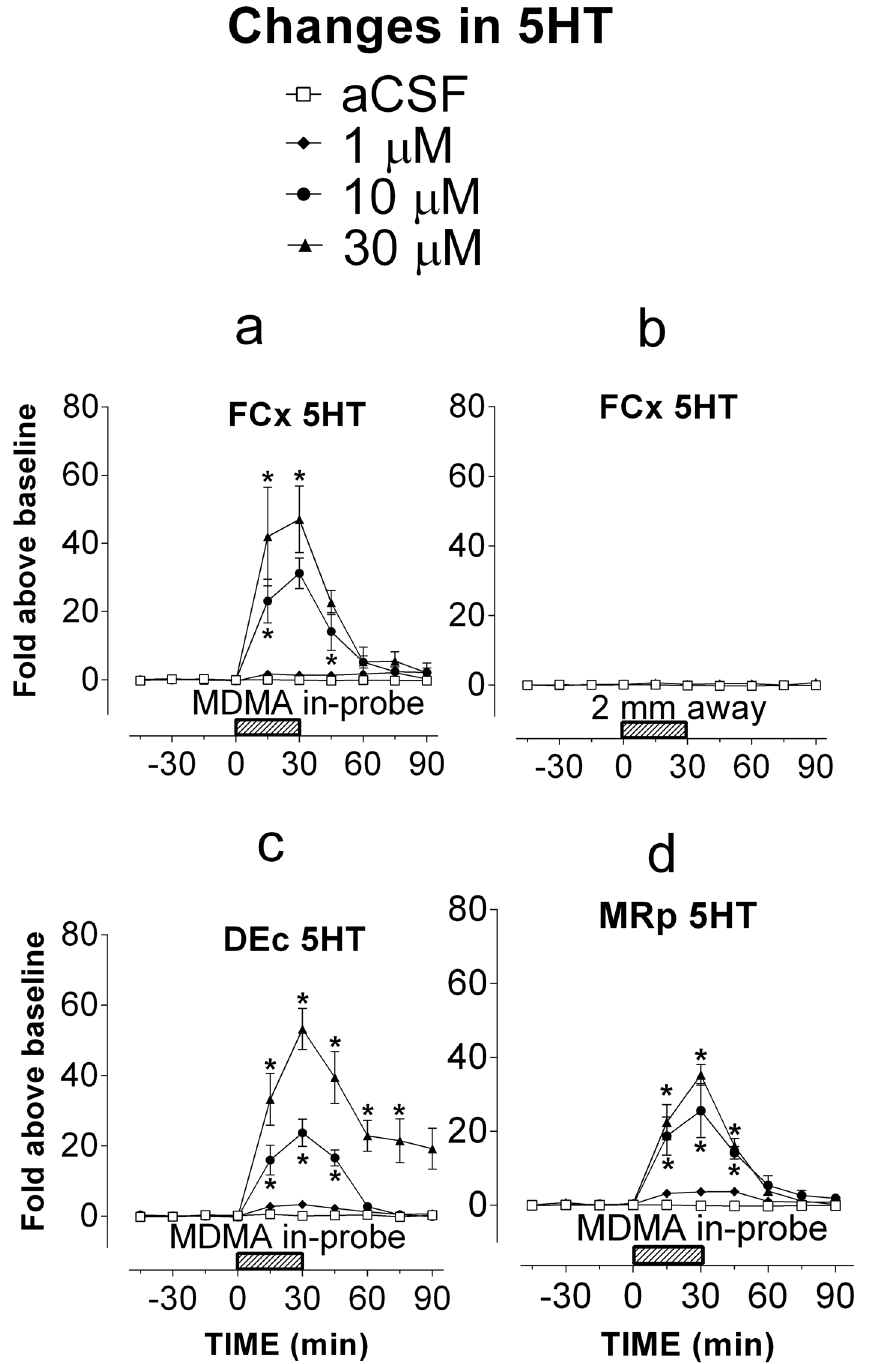
Fig 2. Relationship between intracranial administration of MDMA and occurrence of serotonin syndrome in male Sprague-Dawley rats. The route of intracranial administration was reverse microdialysis. Serotonin syndrome was determined by measuring extracellular 5HT in the delivery sites (FCx, DEc and MRp), or a site at 2 mm away from the delivery site. Hatched horizontal bars indicate the time period of reverse microdialysis at MDMA concentrations of 0 (aCSF; □ ), 1 μ M ( ◆ ), 10 μ M ( ● ) or 30 μ M ( ▲ ). Data are expressed as mean ± s.e.m. a, Reverse microdialysis in the FCx caused concentration-dependent elevation at the delivery site (n = 4 – 6 rats/group). b, Reverse microdialysis of 30 μ M MDMA in the FCx had no effect on extracellular 5HT in the site at 2 mm away from the delivery site (see Materials and Method section).